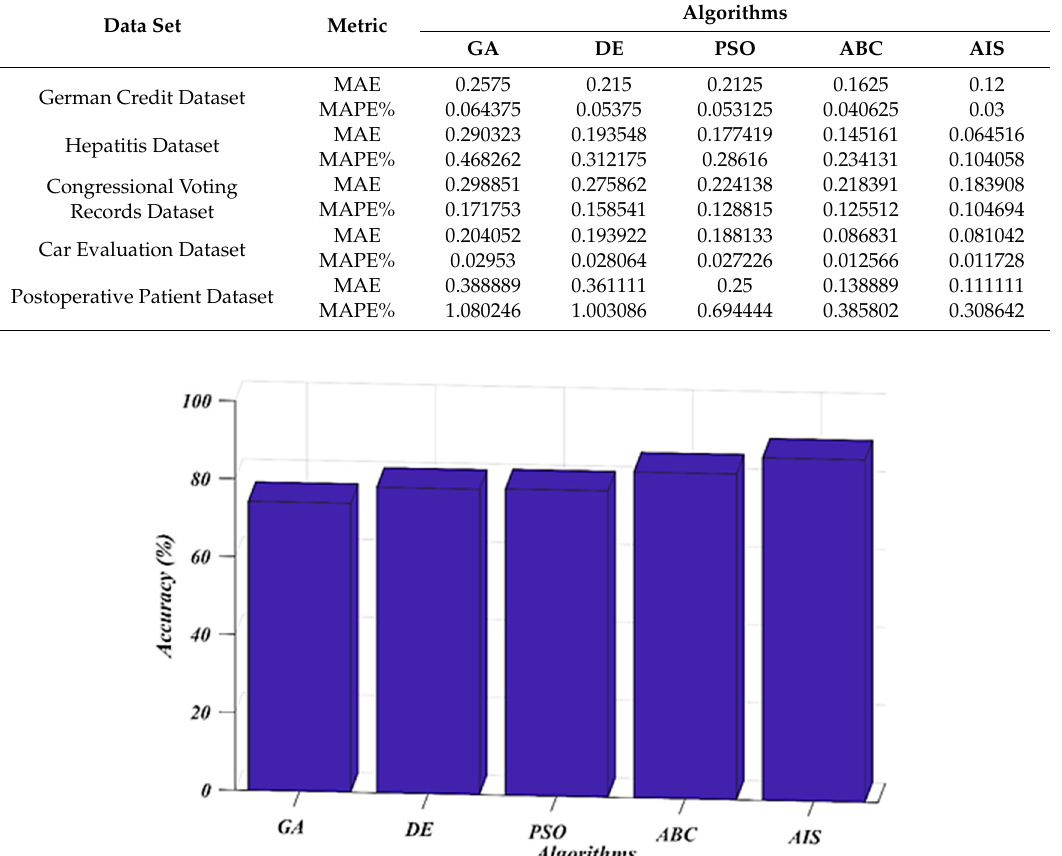
Figure 10. Accuracy Evaluation for Congressional Voting Records. Figure 11. Accuracy Evaluation for Car Evaluation.